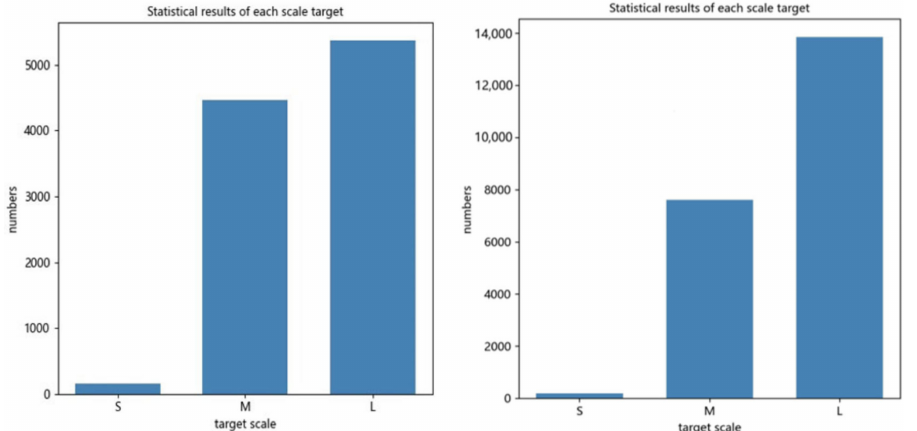
Figure 10. ( Left ) Distribution of targets by scale for EDS_5k. ( Right ) Distribution of targets by scale for